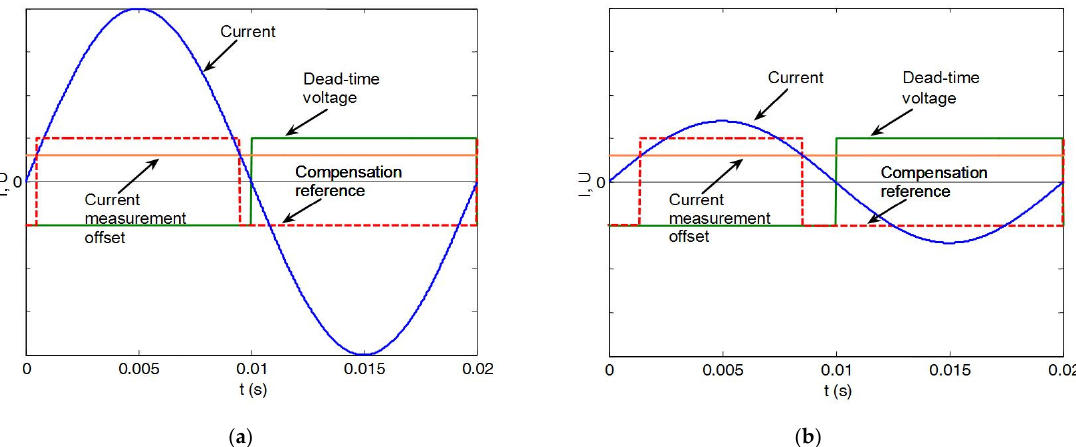
Figure 5. Dead time voltage compensation malfunction caused by current measurement offset: ( a ) larger current magnitude; ( b ) smaller current magnitude [3].